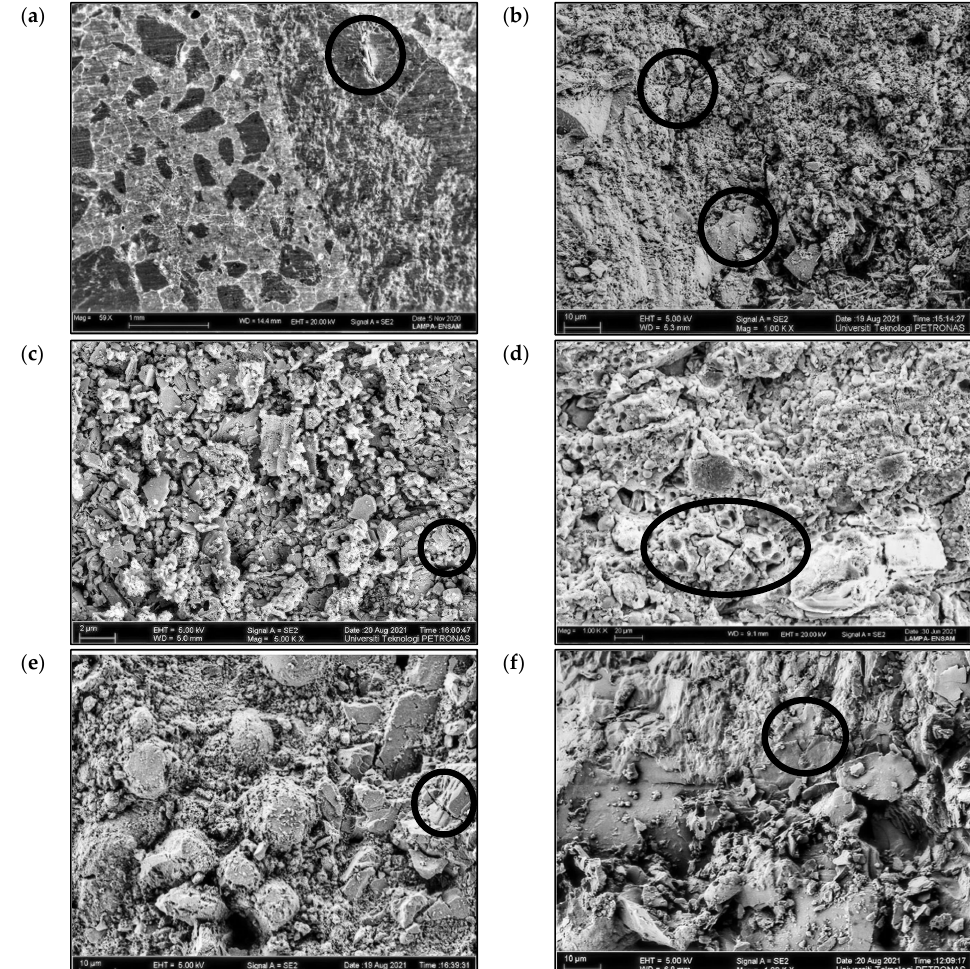
Figure 6. SEM images of ( a ) OPC40 at 20 °C; ( b ) OPC40 at 500 °C; ( c ) OPC40 at 1200 °C; ( d ) GEO40 at 20 °C; ( e ) GEO40 at 500 °C; ( f ) GEO40 at 1200 °C.